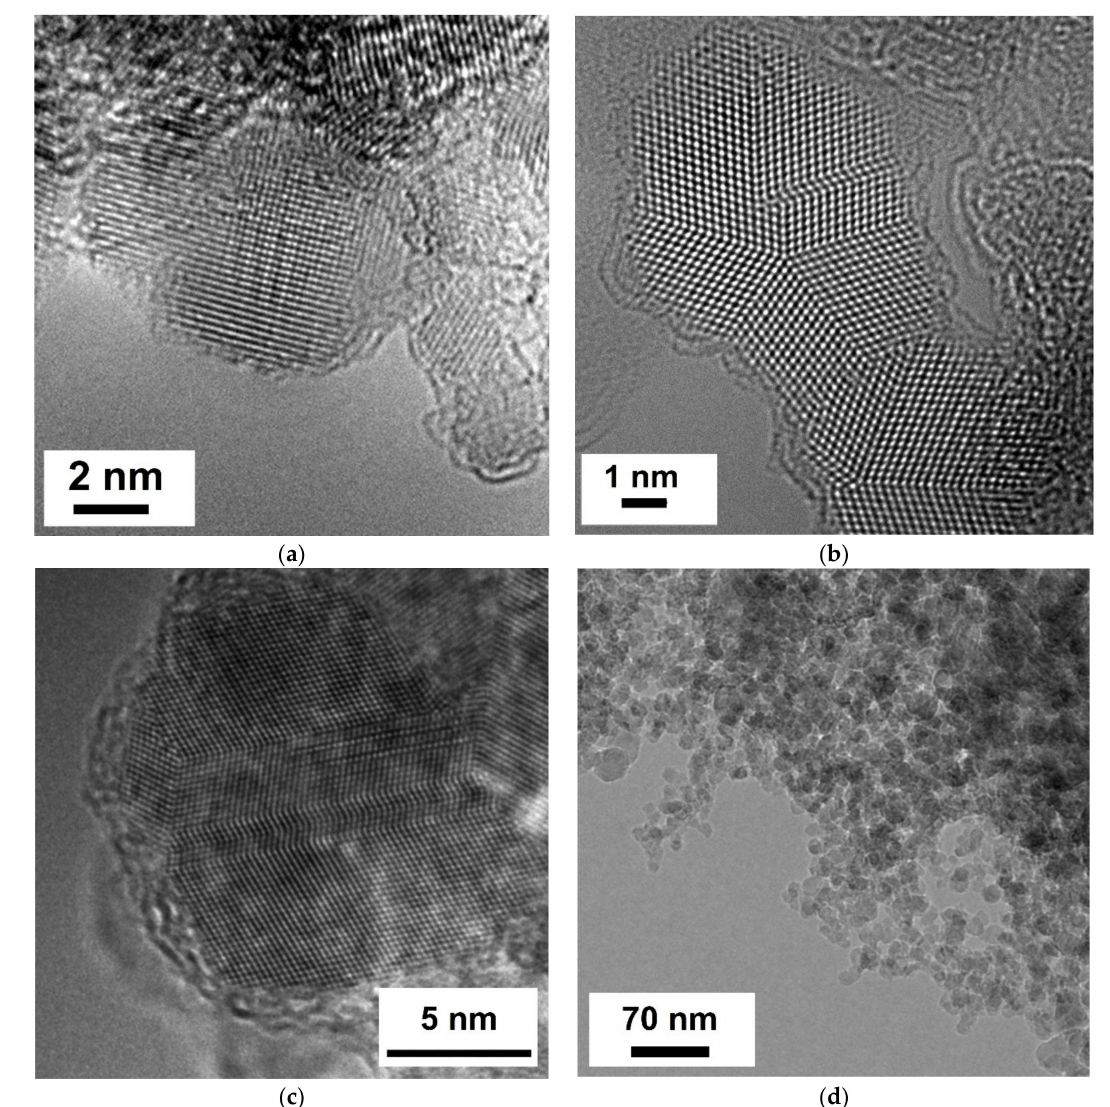
Figure 1. Nanodiamonds of detonation synthesis: ( a ) primary nanodiamond particle without crystalline defects; ( b , c ) nanodiamonds with twins; and ( d ) agglomeration of